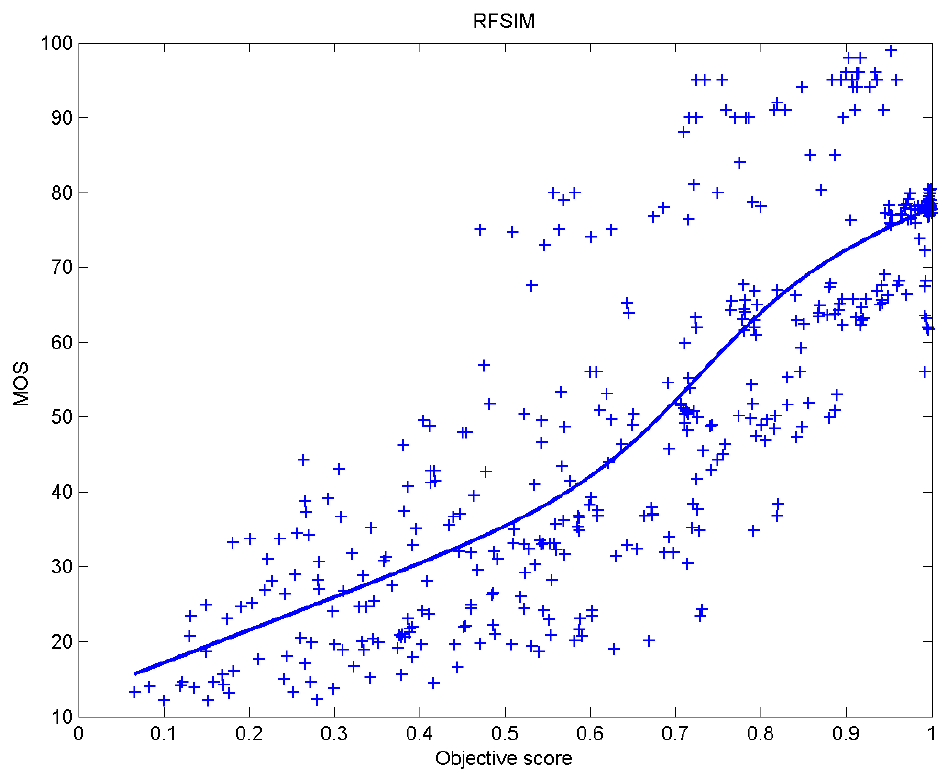
Figure 17. Scatter plots of the subjective scores (MOS) vs. RFSIM.